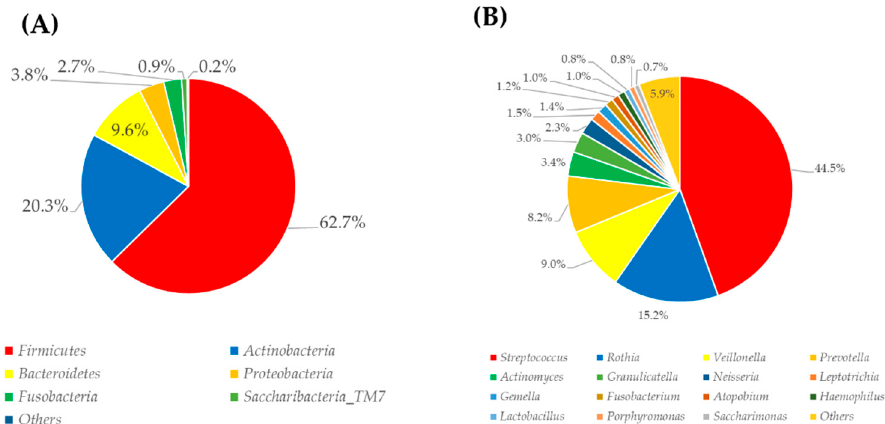
Figure 1. Microbiome structure in saliva: ( A ) phylum level; ( B ) genus level.